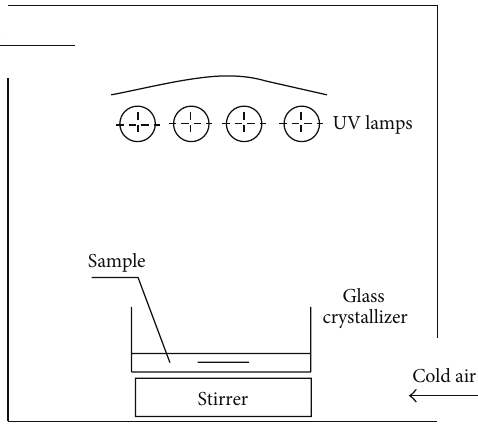
Figure 1: The scheme of test stand.